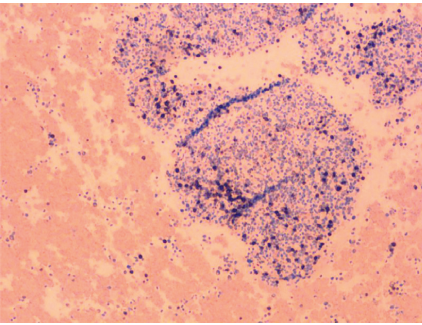
Figure 4: Clot stained with CD2 which is positive in mast cells.